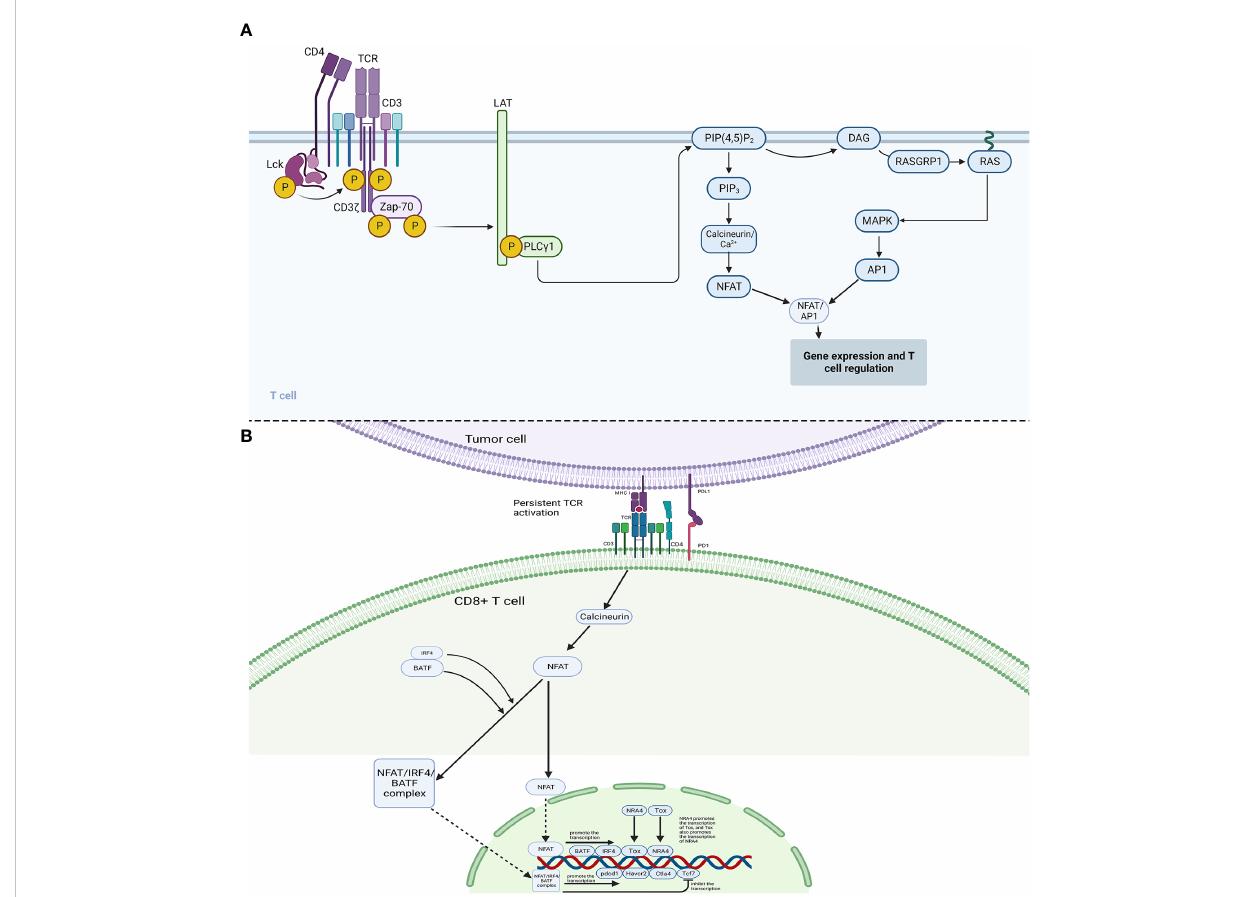
FIGURE 2 Mechanisms of CD8 + T cell regulation and exhaustion. (A) : In acute infection, phosphorylated Lck phosphorylates CD3 and z chains, which then link ZAP-70. ZAP-70 could phosphorylate LAT, and then LAT would bind PLC g 1, which activates PIP(4,5)P2. Subsequently, in one pathway, PIP(4,5)P2 activates DAG/RAS/MAPK and AP1, in another pathway, PIP(4,5)P2 could induce the activation of Calcineurin/Ca+ and NFAT. (B) : In the case between tumor cells and CD8+ T cells, the interaction between PD1 and PDL1 interferes the original powerful immune-activated pathways, which could induce abnormal NFAT signaling to promote Tex. Continuous TCR activation leads to the activation of calcineurin pathways, which dephosphorylates the cytoplasmic nuclear factor of activated T cells (NFAT). The cytoplasmic NFAT would then translocate into the nucleus and promote transcription of BATF, IRF4, Tox, and NRA4. Cytoplasmic BATF and IRF4 proteins could also cooperate with cytoplasmic NFAT protein (NFAT/IRF4/BATF complex), which then translocates into the nucleus. The nuclear NFAT/IRF4/BATF complex could promote the transcription of inhibitory receptor genes, including pdcd1(PD-1), Havcr2(TIM-3), and Ctla4(CTLA-4), and repress the gene